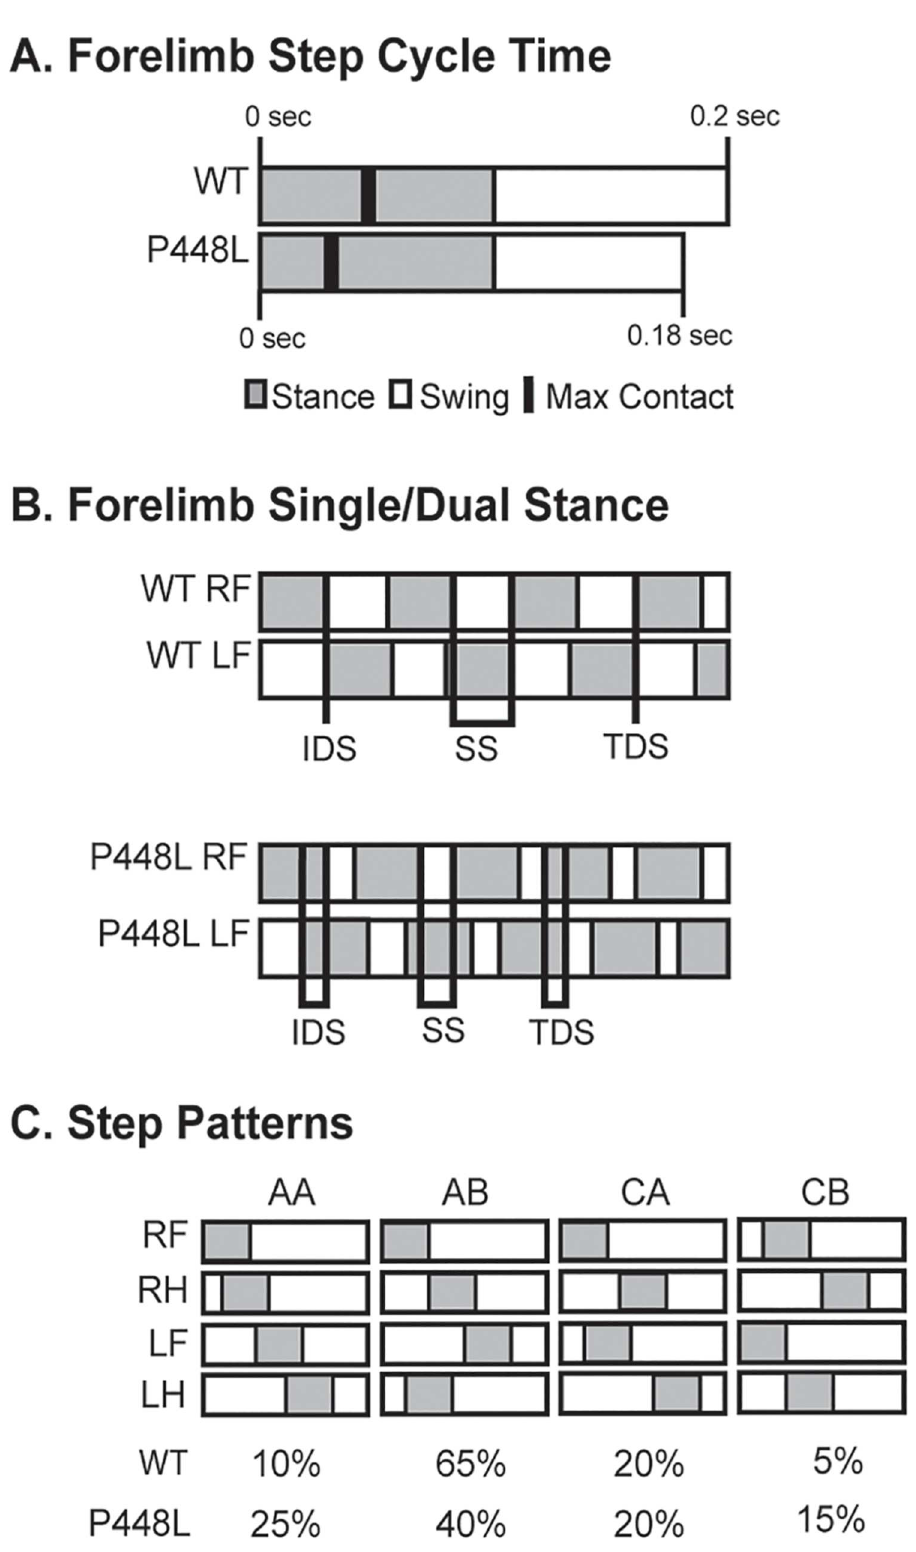
Fig 9. Gaitsummary. (A) Visual representation of the step cycle over time in wild-type(WT)and P448L mice. Each bar signifies a single step cycle lastingthe indicatedtime. Stand phase represents a